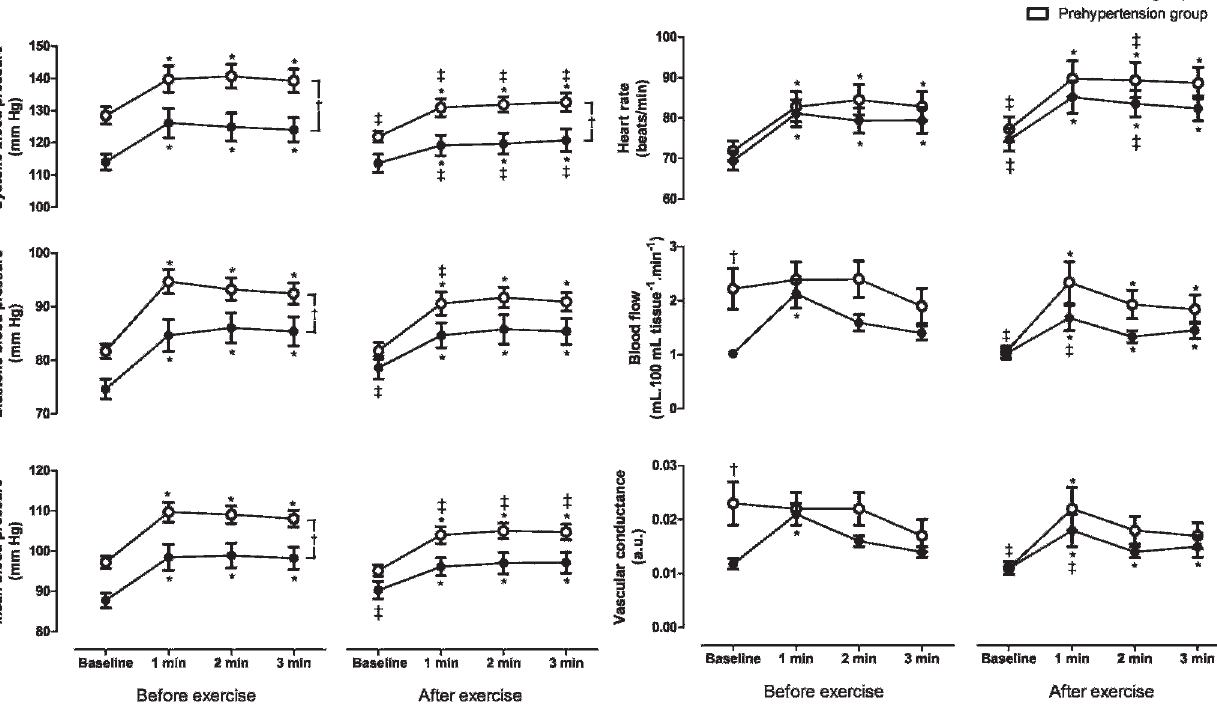
Figure 1 - Absolute hemodynamic responses to mental stress, adjusted for gender, before and after an exercise bout in subjects with prehypertension or normotension. Values are the mean ¡ SEM. *, p , 0.05 vs. within-group baseline; { , p , 0.05 vs. same condition between groups; { , p , 0.05 vs. before-exercise